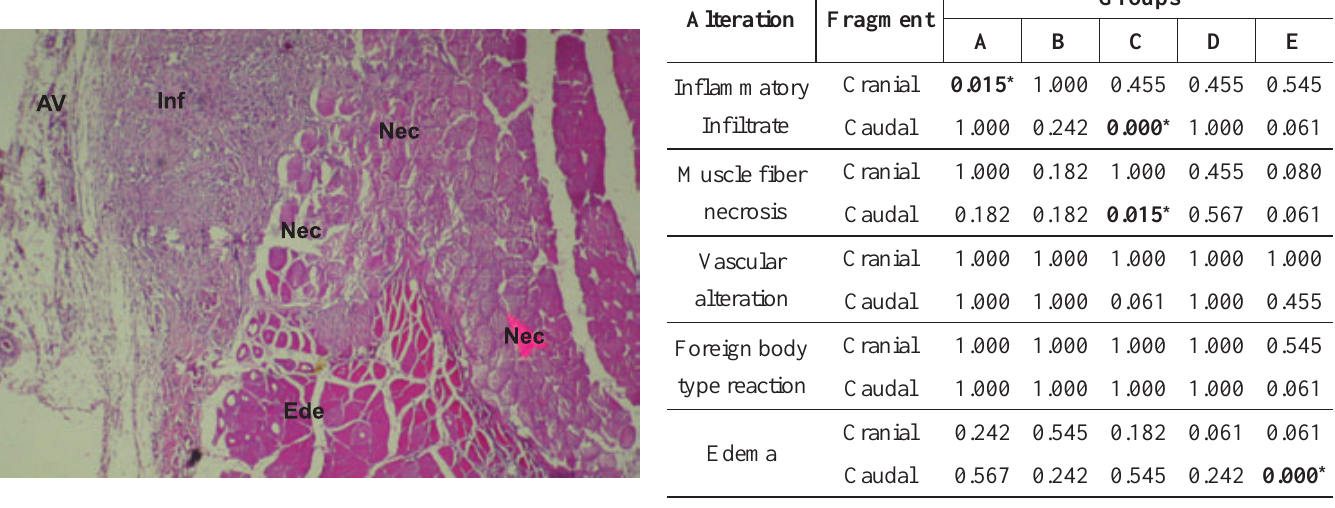
FIGURE 6 – Group C – colored with HE (50x). Histological cut of the caudal fragment of the right rectus abdominis muscle. Inf= inflammatory infiltrate (++), Nec= muscle fiber necrosis (++), AV= vascular congestion (+), Ede= edema (++).